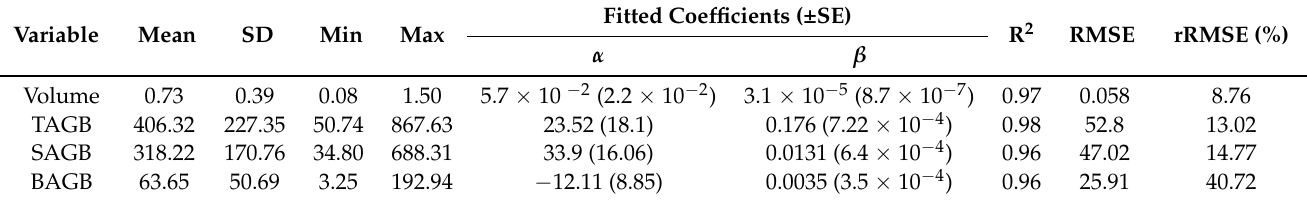
Table 1. Fitted coefficients and their standard errors when predicting tree volume (v), total above- ground biomass (TAGB), stem biomass (SAGB), and branch biomass